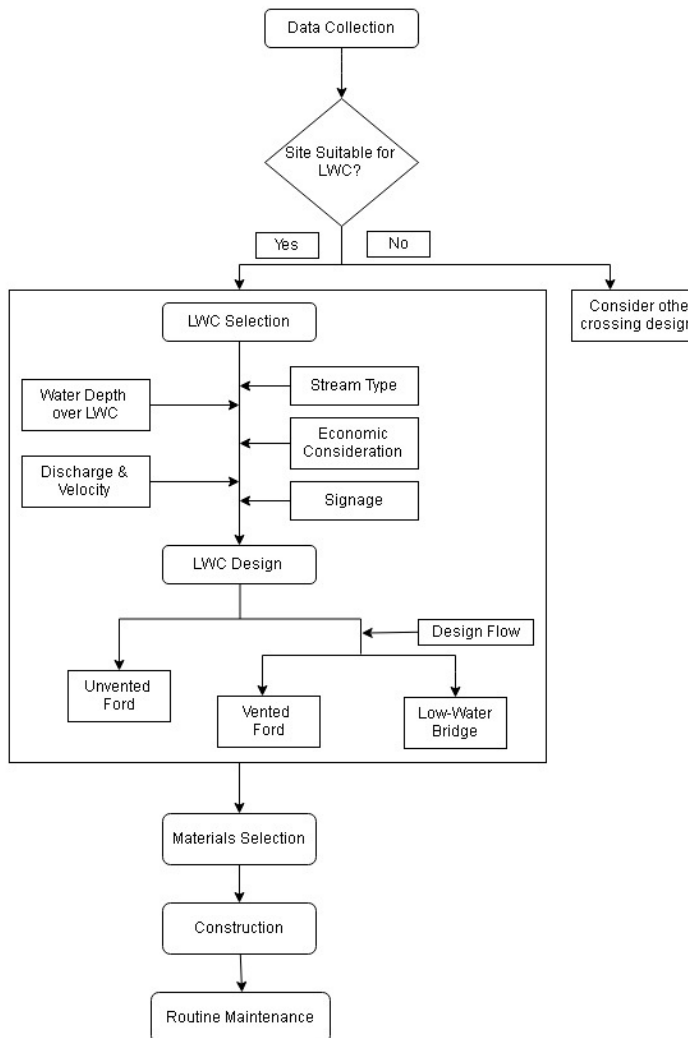
Figure 5. Flowchart for LWC selection, design, and construction.